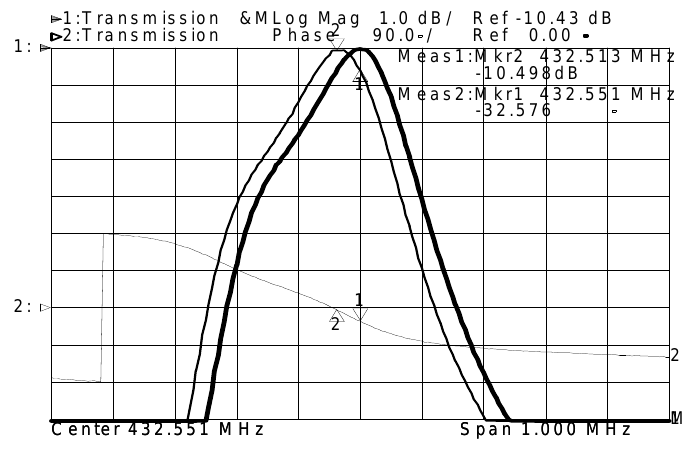
Figure 2. Frequency responses (upper curves) and phase response (lower curve) of a polyisobutilene (PIB) coated RSAW sensor prior to (right curve) and after (left curve) tetrachloroethilene vapors are applied to the sensor